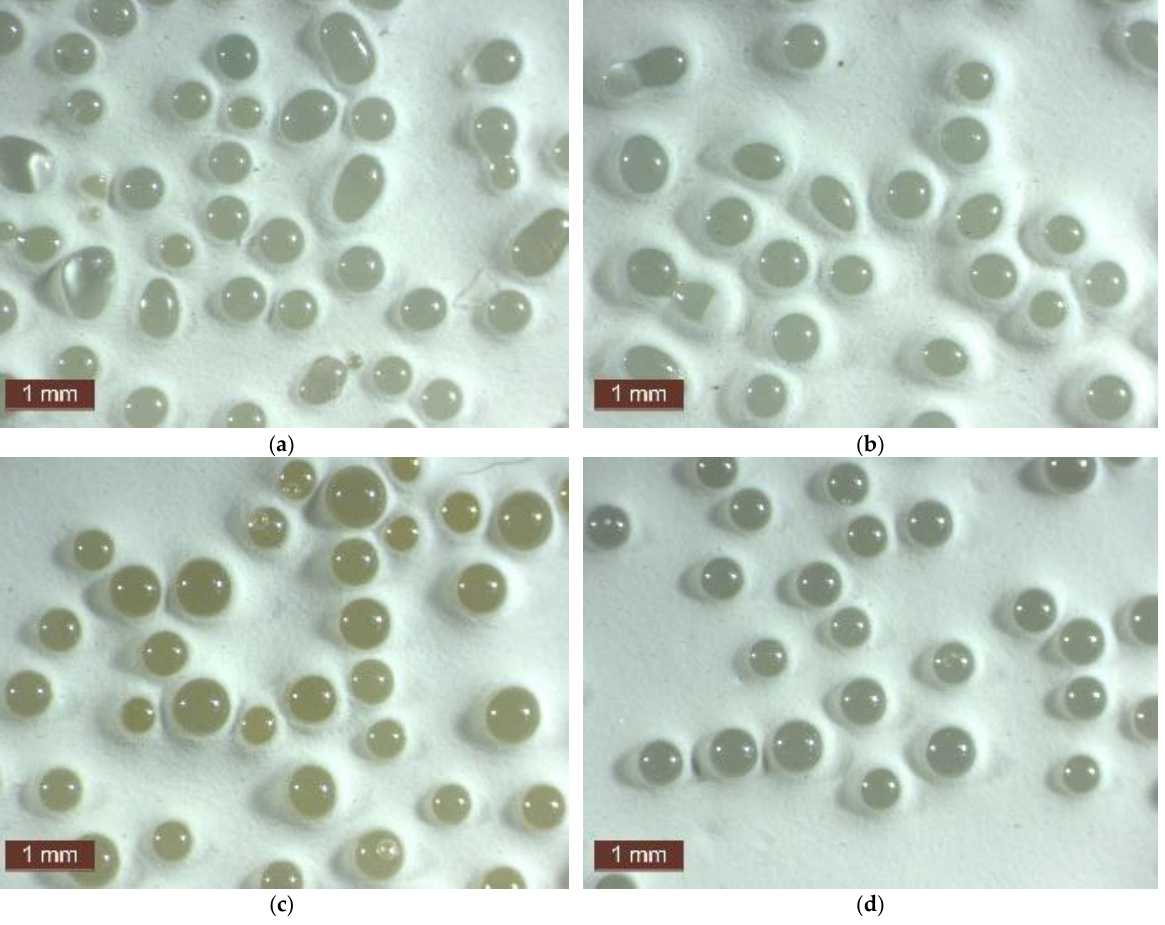
Figure 4. Microscope images (magnification 4×) of freshly applied GB: ( a ) standard (sample SF ), ( b ) large (sample ML ), ( c ) premium (sample SP ), ( d ) high index (sample HI ).